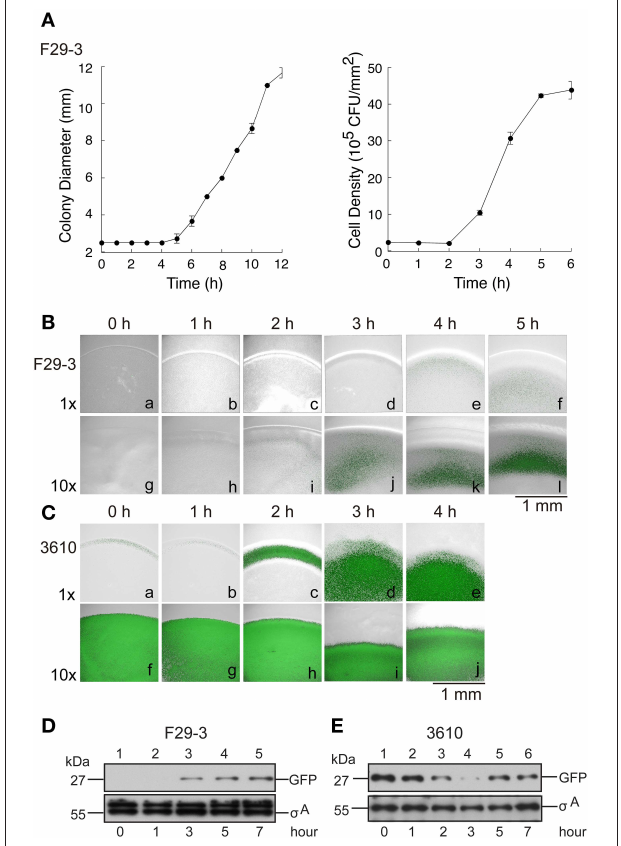
FIGURE 8 | Quorum sensing and its role in swarming. (A) LB-0.4 plates were inoculated with B. subtilis F29-3. The size of the colonies was measured with a ruler. Cell numbers were counted by plating cells from swarms cultured on LB-1.5 agar. Cell density (CFU/mm 2 ) was then calculated. The size of the colony and the cell numbers were determined by three independent experiments. Error bar represents standard deviation. Confocal micrographs of (B) B. subtilis F29-3(pSrf-gfp) and (C) B. subtilis 3610(pSrf-gfp) colonies that were respectively cultured on LB-0.4 and LB-0.7 agar plates (gray); the green color indicates the presence of GFP. Plates were inoculated with overnight cultures that were unconcentrated (1 × ), or log-phase cells that were concentrated 10-fold (10 × ). (D) LB-0.4 and (E) LB-0.7 agar plates were respectively inoculated with 10 µ l 10-fold concentrated B. subtilis F29-3 or 100 µ l unconcentrated B. subtilis 3610 overnight cultures. Bacteria were subsequently cultured for the time indicated. GFP and σ A in the cell lysates were analyzed by immunoblotting. The amounts of σ A were used as a loading control. A band larger than that of σ A in strain F29-3 was nonspecifically detected by anti- σ A